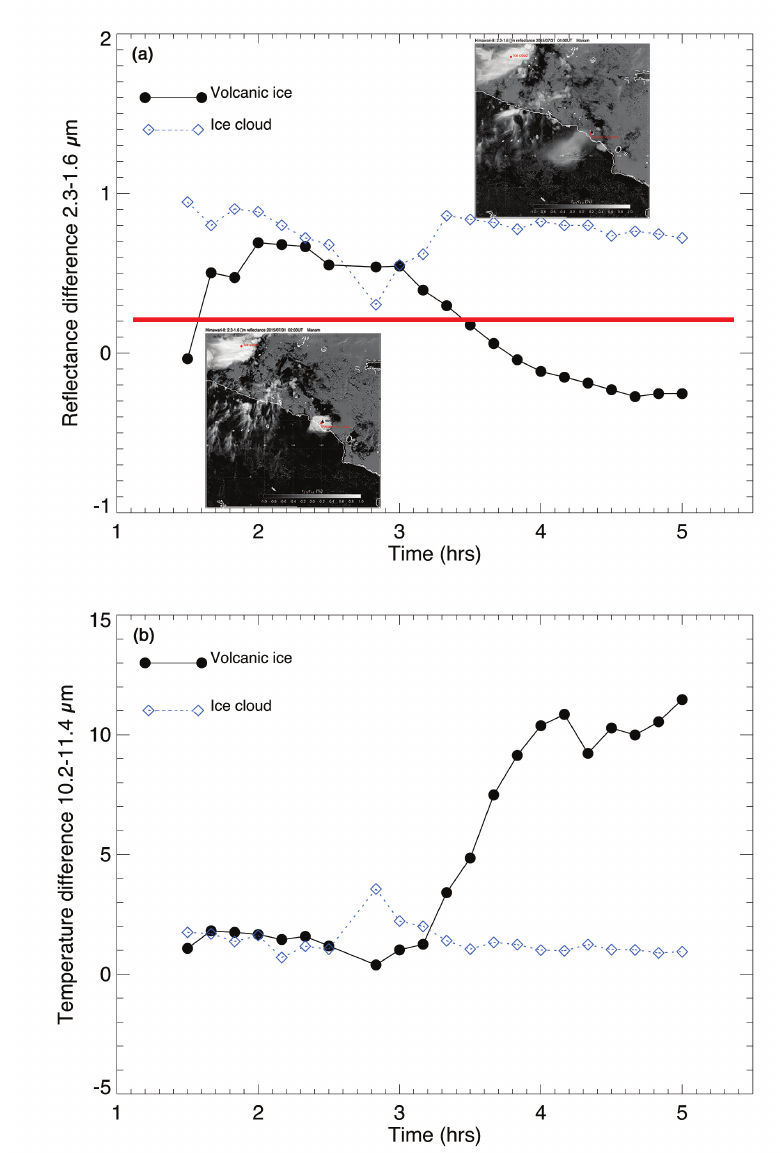
Figure 20. Time-series of: ( a ) reflectance differences (2.3–1.6 µ m) and ( b ) brightness temperature differences (10.2–11.4 µ m), for two locations in Himawari-8 imagery for the 31 July 2015 Manam eruption. The locations were chosen to be close to the erupting column (white line and dots) and near a meteorological ice cloud (blue line and diamonds) upwind from the erupting volcano. The locations of the sites are shown in the 2.3–1.6 µ m difference sub-images in ( a ) taken at 02:00 and 04:00